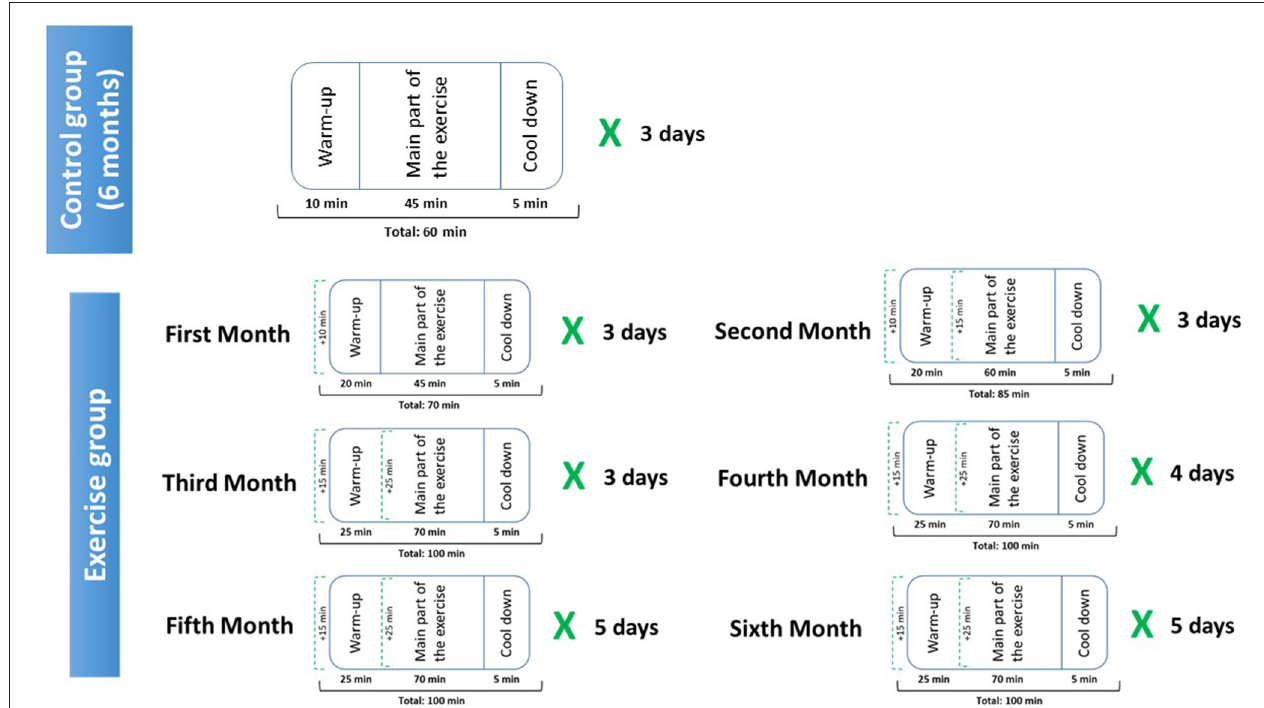
FIGURE 1 | Physical exercise